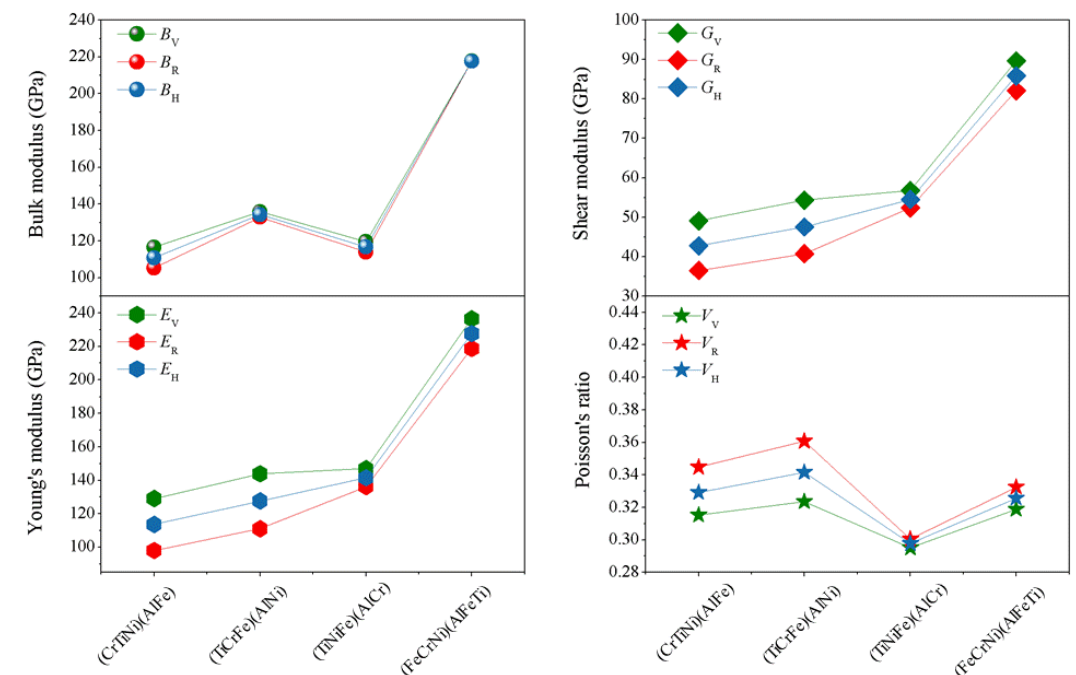
Figure 4. The calculated average properties (bulk modulus ( B ), Shear modulus ( G ), elastic modulus ( E ) and poisson’s ratio ( ν )) for single-phase AlCrTiFeNi of different atom occupancy positions by using Voigt-Reuss-Hill approximation. (TiCrNi)(AlFe); (TiCrFe)(AlNi); (TiCrFe)(AlCr); (FeCrNi)(AlFeTi) is the positions occupied by atoms.